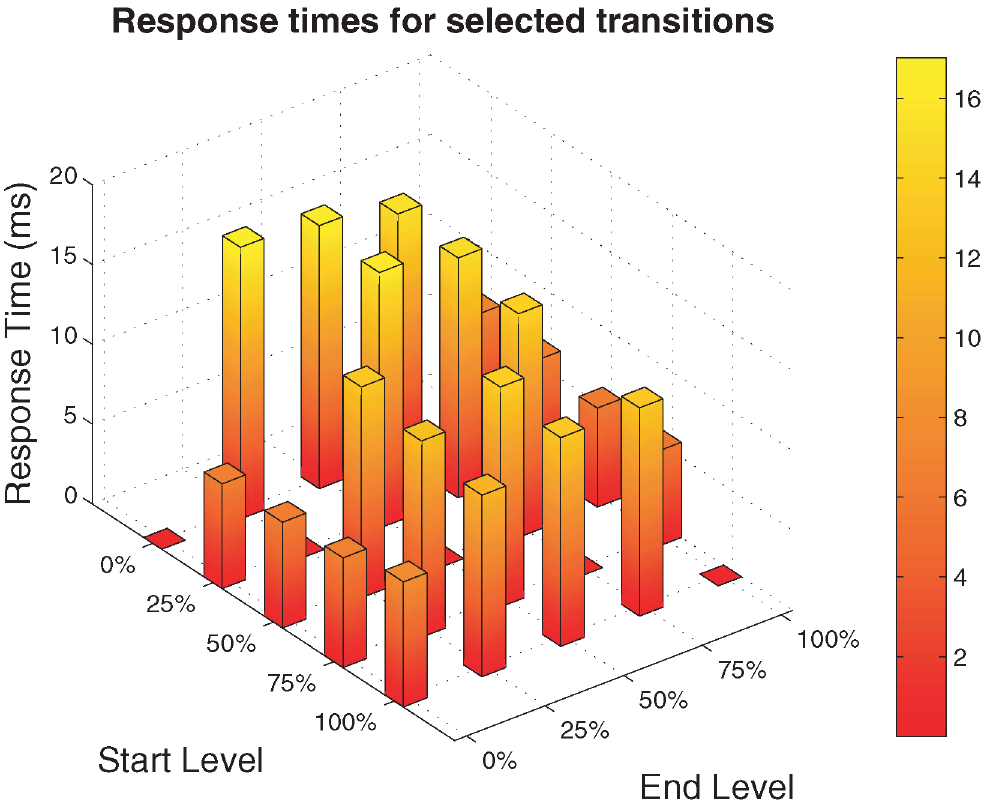
Figure 3. Response times variability over different luminance levels (Dell 3007 WFP LCD panel, green channel). The bar plots show averaged response times over five measurements. Response times have been measured from five different initial levels (given as percentage of the maximal luminance of the monitor) to five target levels. All response times have been calculated by means of the division method with dynamical filtering [13].